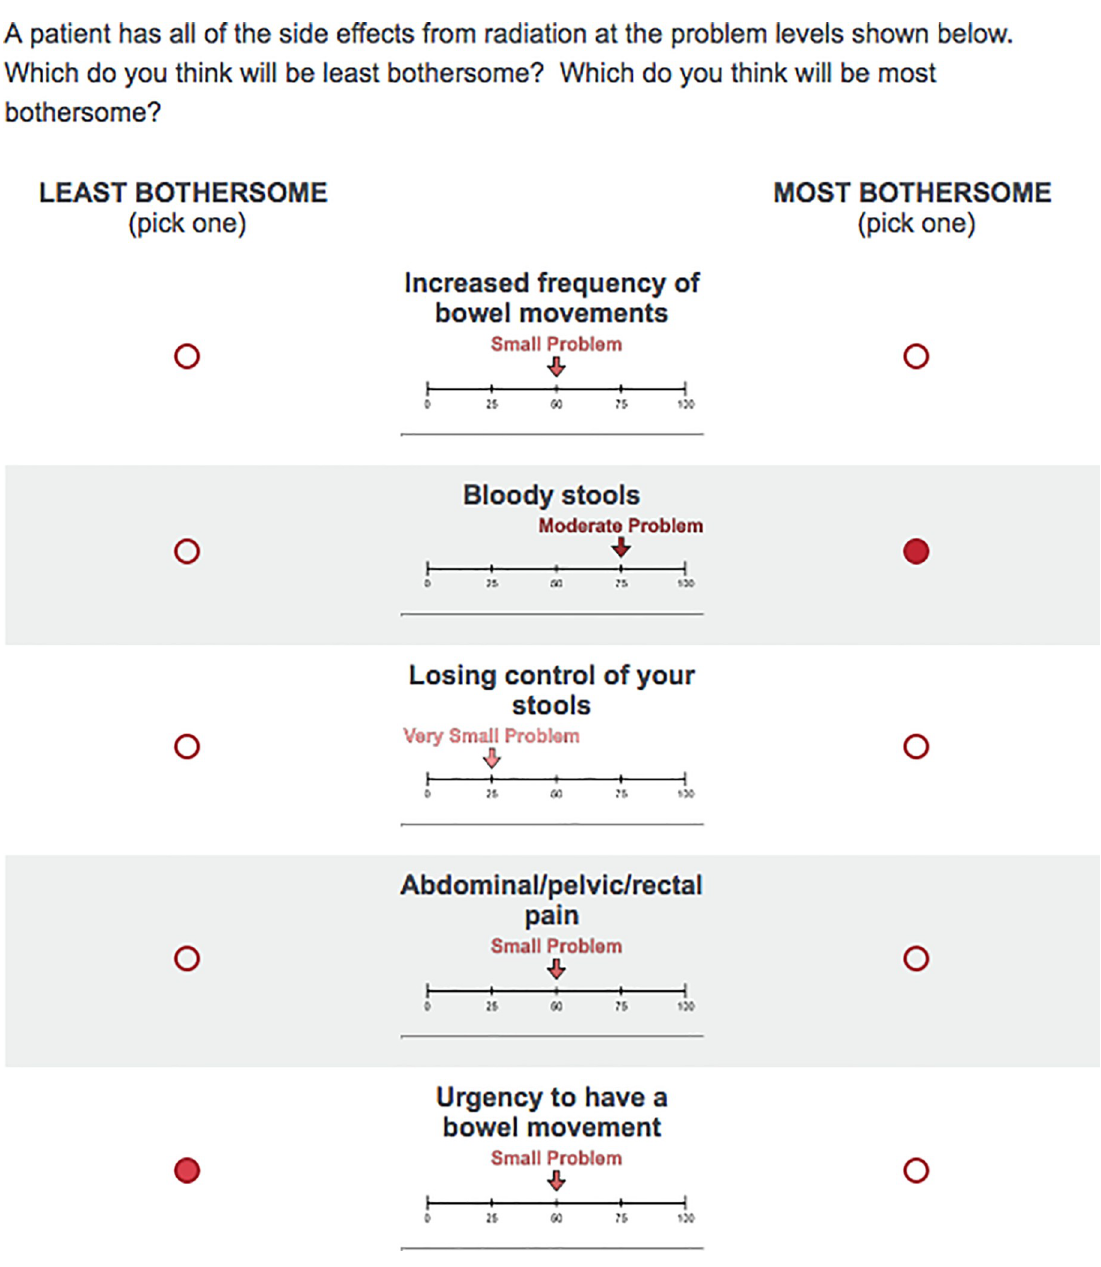
Fig 1. An example of a task as shown to